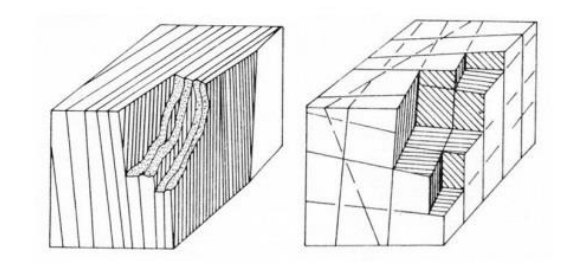
Figure 1. Effect of the number of joint sets on the mechanical behavior and appearance of a rock mass.